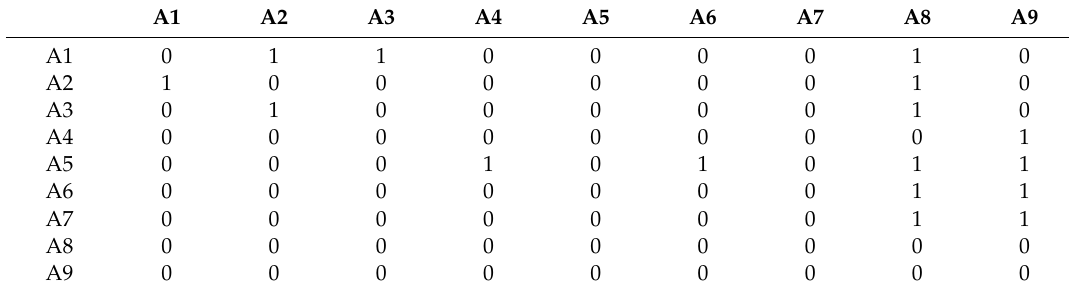
Table 7. The comparison matrix of the cumulative index.